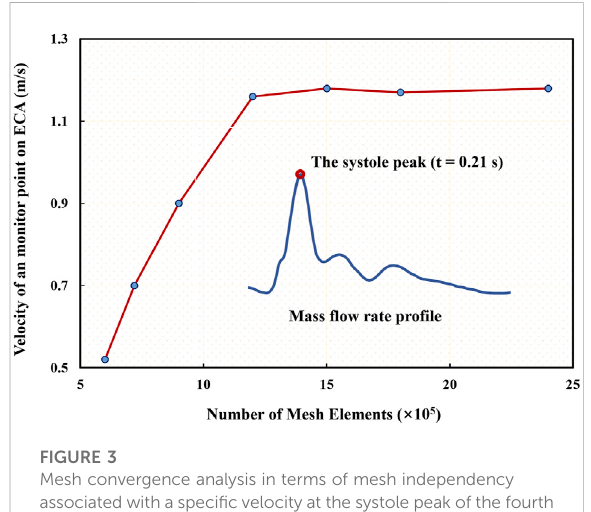
FIGURE 3 Mesh convergence analysis in terms of mesh independency associated with a speci fi c velocity at the systole peak of the fourth cycle.